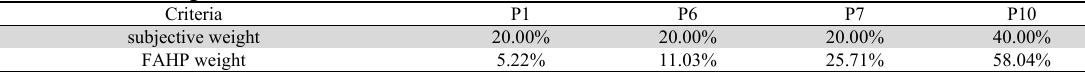
Subjective vs. FAHP weight distributions of selected